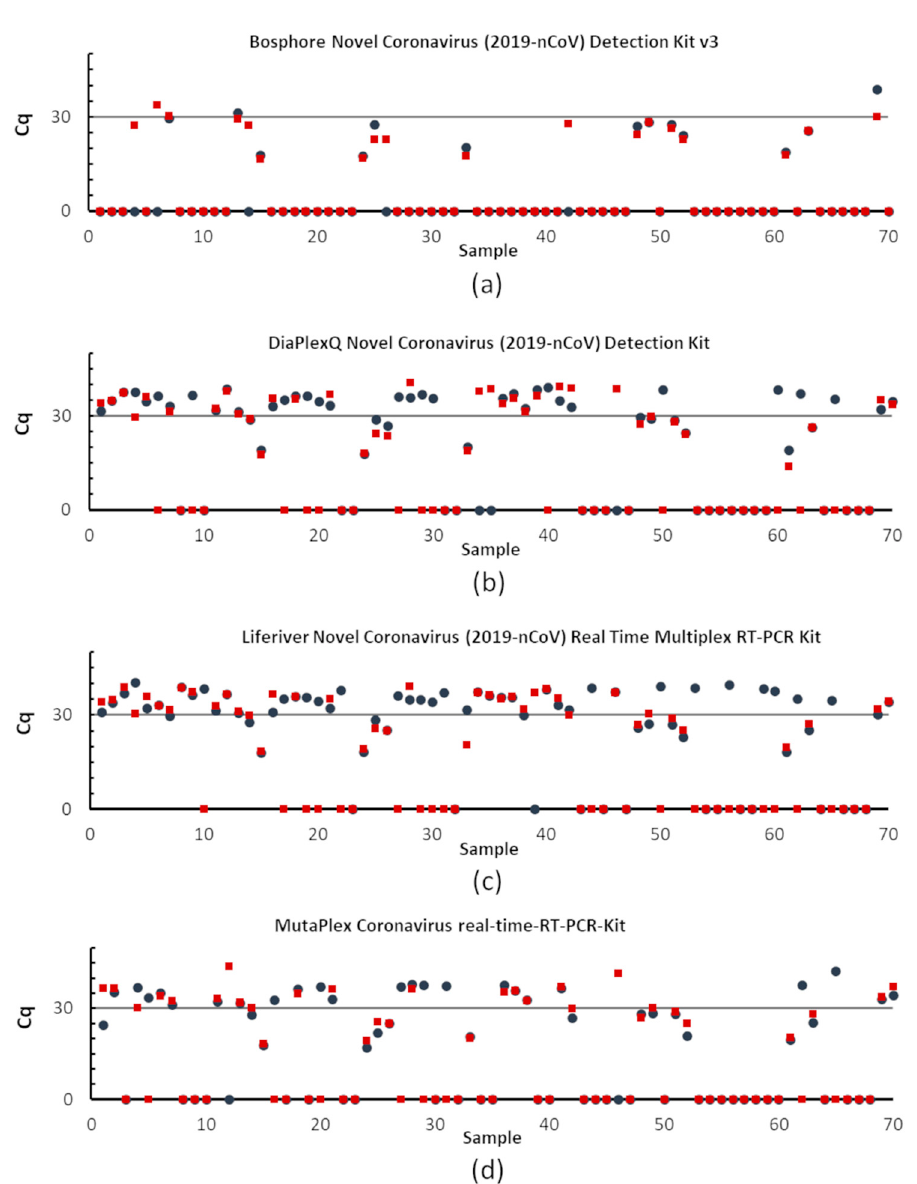
Figure 4. Diagnostic sensitivity impact of the applied RT-qPCR assays. RNA from the panel of 70 samples was extracted using column—(blue circles) and magnetic (red squares)-based methods. The graphs present Cq values for each specimen analyzed by four commercial RT-PCR kits detecting SARS-CoV-2, ( a ) Bosphore, ( b ) DiaPlexQ, ( c ) Liferiver, and ( d ) MutaPlex. Here, the Cq value is shown only for one of the tested regions, ( a – c ): Orf1ab, ( d ): RdRp—a fragment of Orf1ab gene; Cq equal to 0 means no amplification was observed.